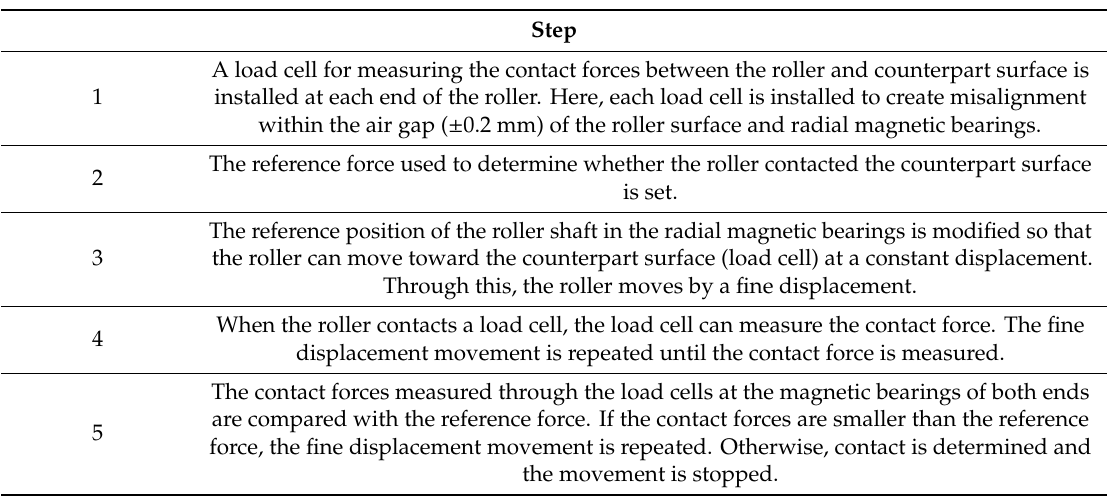
Table 2. Sequence of steps for automatic alignment of